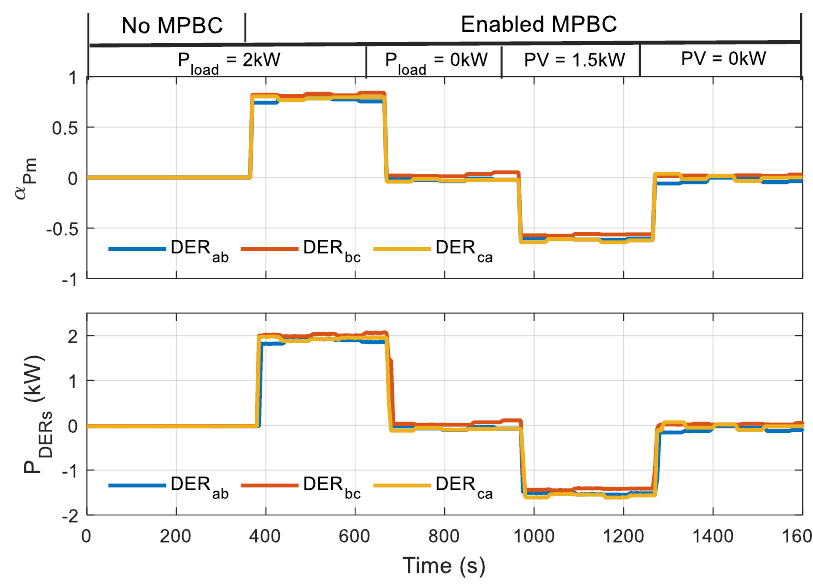
Figure 5. Load power and PCC active power during self-consumption mode.